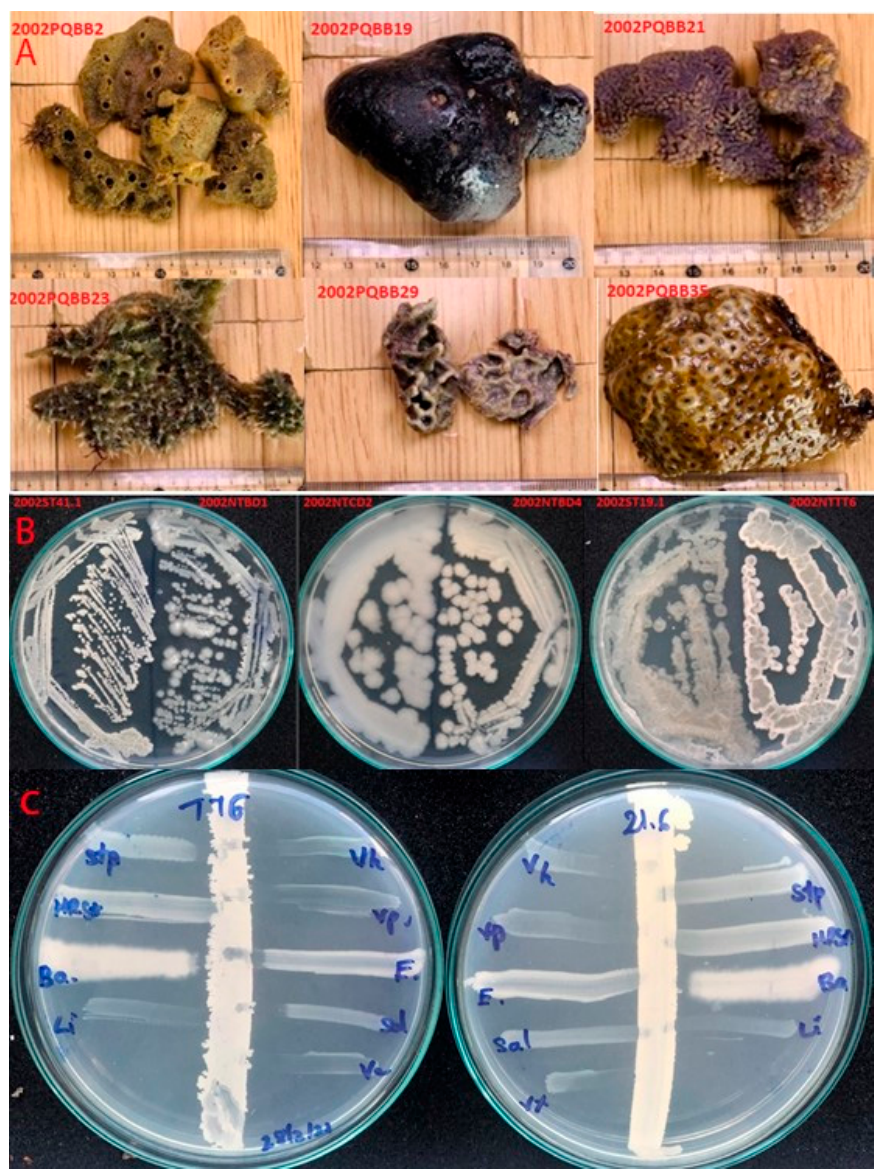
Figure 1. Basic information of isolated Vi+. ( A ) Pictures of marine sponges used for isolation of the sponge-associated Vi+; ( B ) Vi+ appeared to be diverse in colony morphology; ( C ) demonstration of the cross-streak assay for evaluating the antimicrobial spectra of isolated Vi+ from an intestinal Vi+ NTTT6 and a sponge-associated Vi+ PQBB21.6. Reference strains included V. harveyi (Vh) , V . para- haemolyticus (Vp), E. coli (E), S. typhimurium (Sa), S. aureus (Stp), methicillin-resistant Staphylococcus aureus (MRSA), B . cereus (Ba), and L. monocytogenes (Li) .